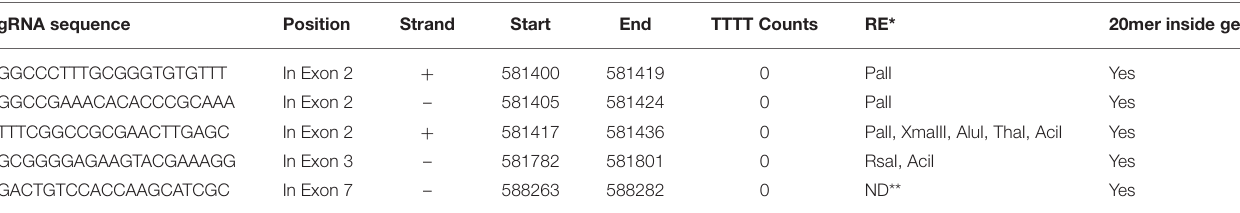
TABLE 3 | Selected gRNAs predicted from JrPDS . gRNA